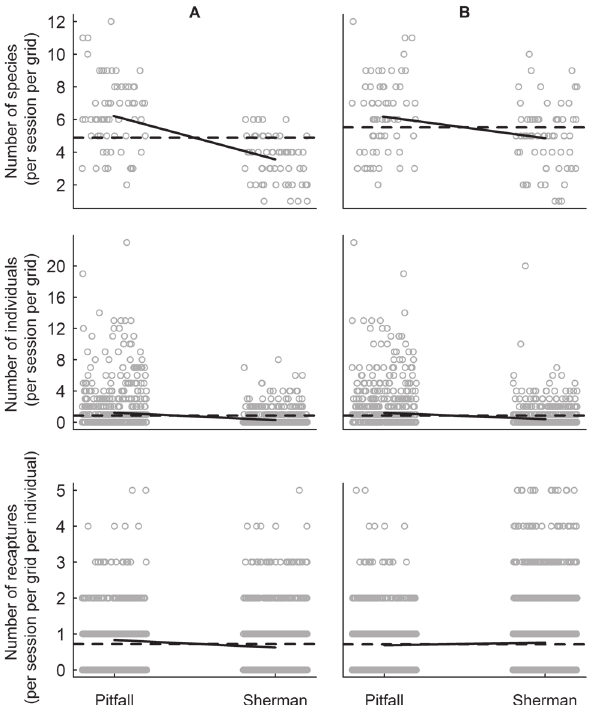
Figure 5. Mortality rates in relation to either the number of captured individuals or the number of captures in pitfall and Sherman traps. Overlapping dots are horizontally scattered to improve visualization. Two data-subsets were used for Sherman traps: only captures from Sherman traps placed adjacent to pitfall lines (column A) or from Sherman traps intercalated with pitfall lines (column B). Expected means for each type of trap estimated from constant models (dashed lines) and from models with trap type as a fixed factor (solid